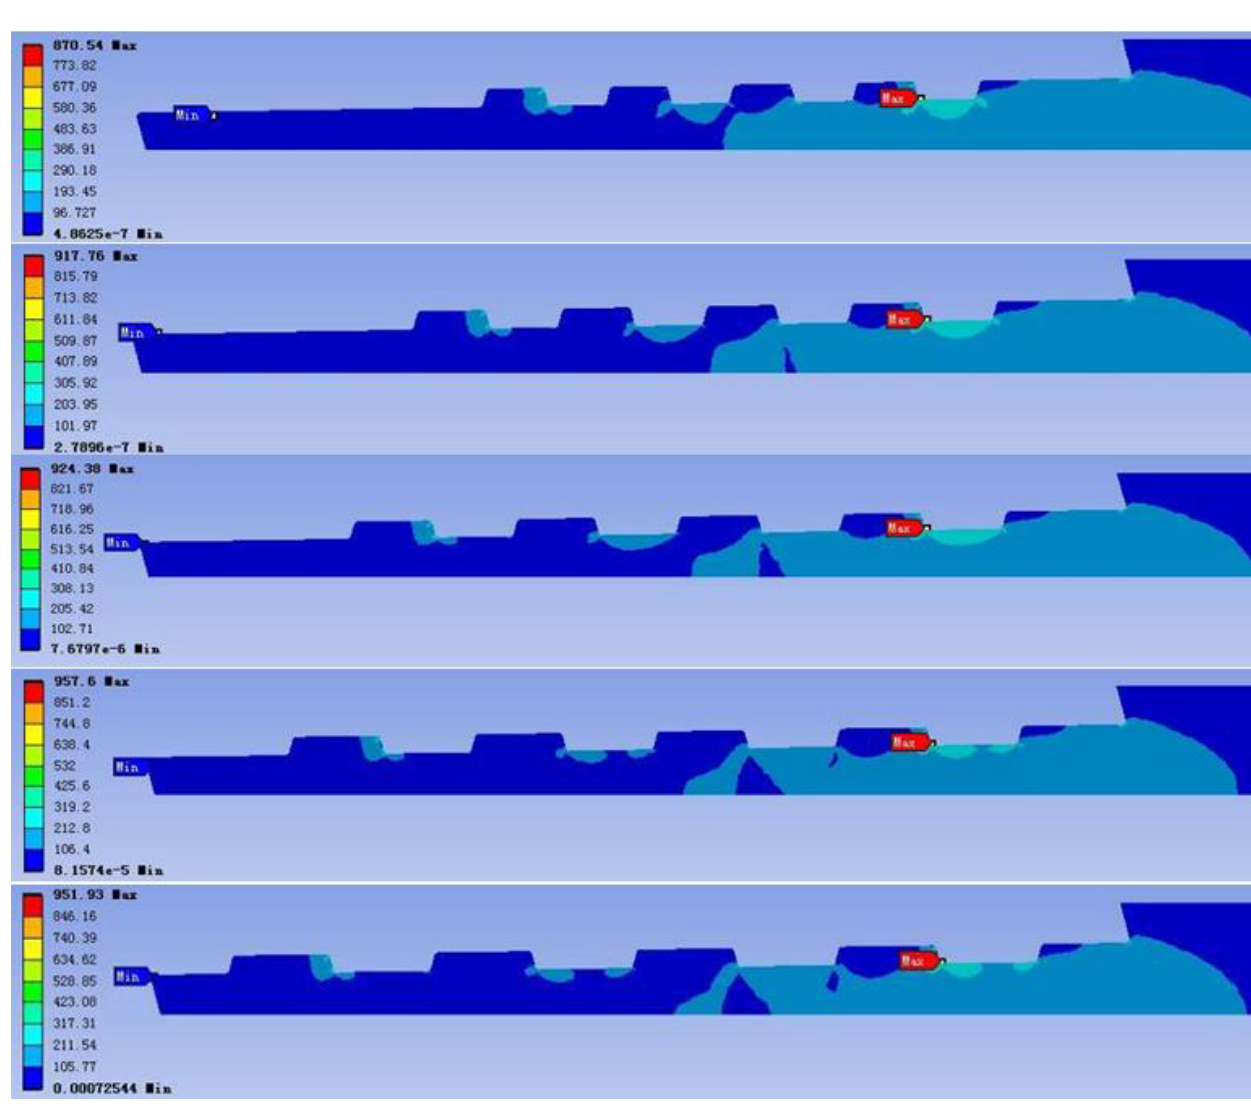
Figure 16. The stress nephogram of the external thread of the confining probe joint (the pitches from top to bottom are 6, 7, 8, 9, and 10mm).